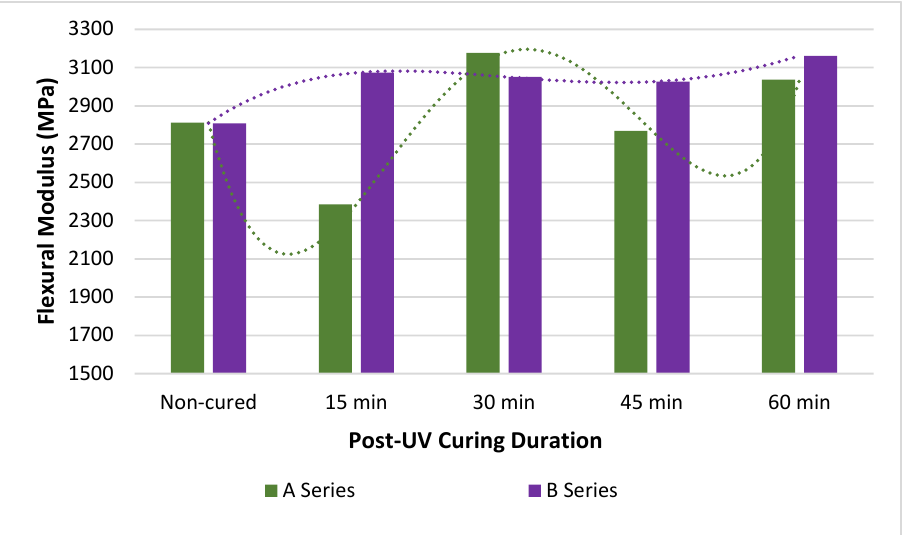
Figure 6. Flexural modulus—post-UV curing duration graph of PLA parts.